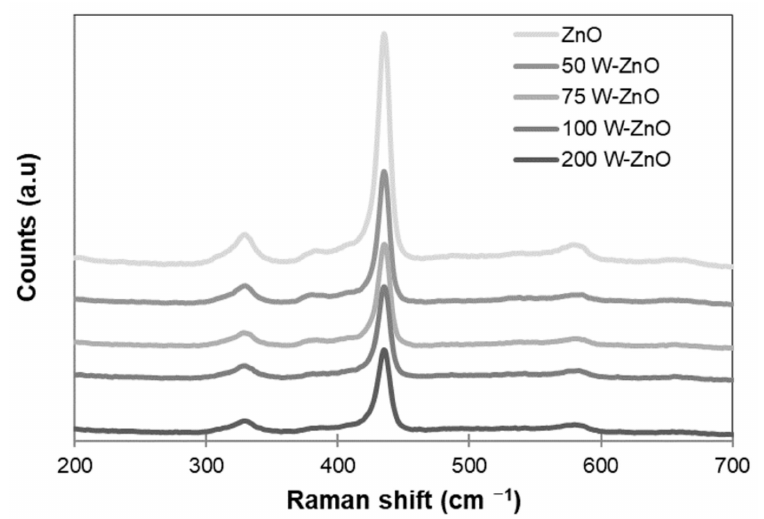
Figure 1. Raman measurements of undoped ZnO and W-doped ZnO photocatalysts in the range 200–700 cm − 1